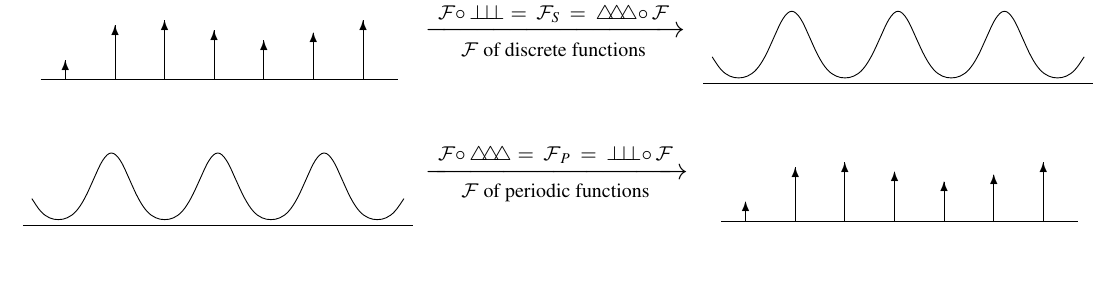
Figure 3. The Discretization-Periodization